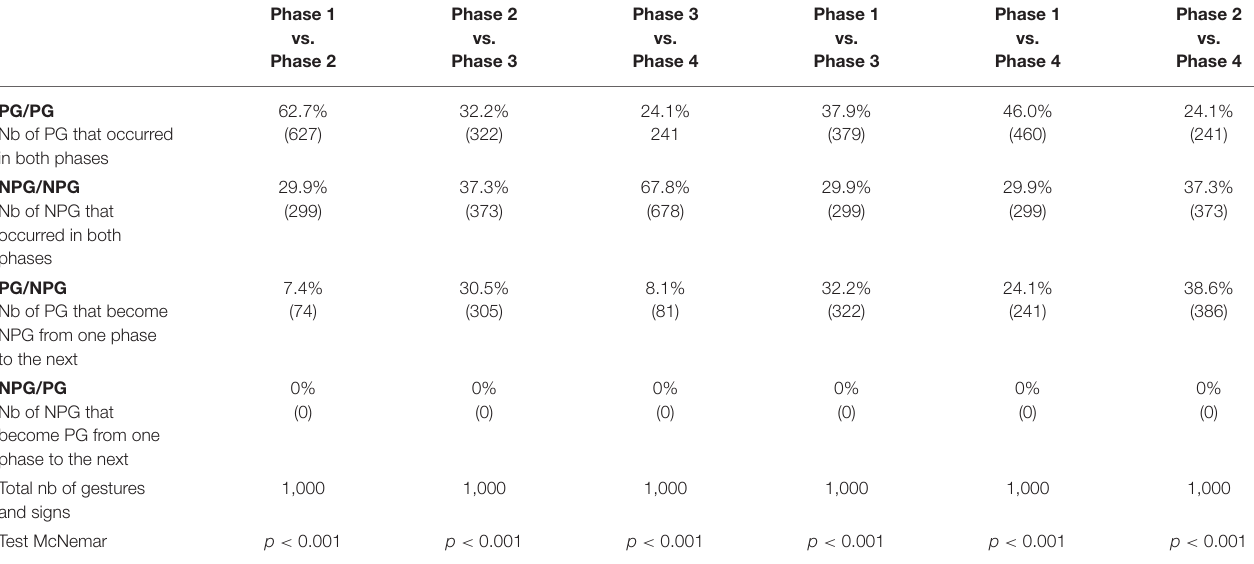
TABLE 1 | McNemar test: Comparison of pair of phases based on the number of occurrences of pantomimic gestures and non-pantomimic gestures in the analyzed 1,000 gestures and